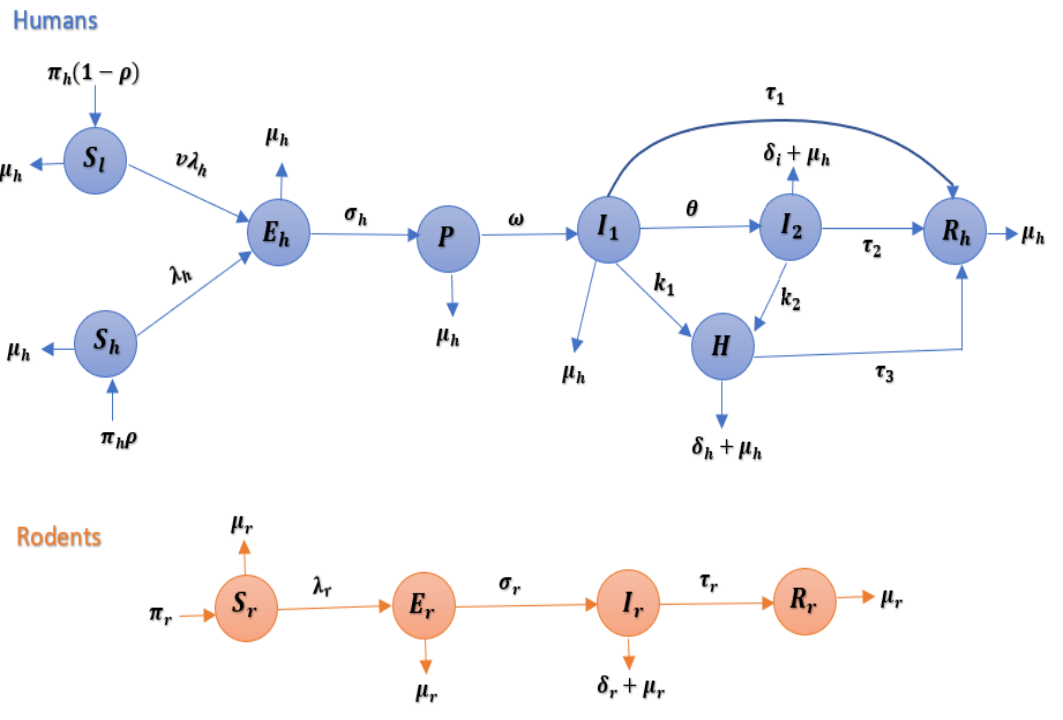
Figure 1. Model (1) representation in a diagram. Transitions are indicated by solid arrows, and per capita flow rate between compartments is indicated by expressions adjacent to the arrows. Blue compartments represent the human population, and the orange compartments represent the ro- dent